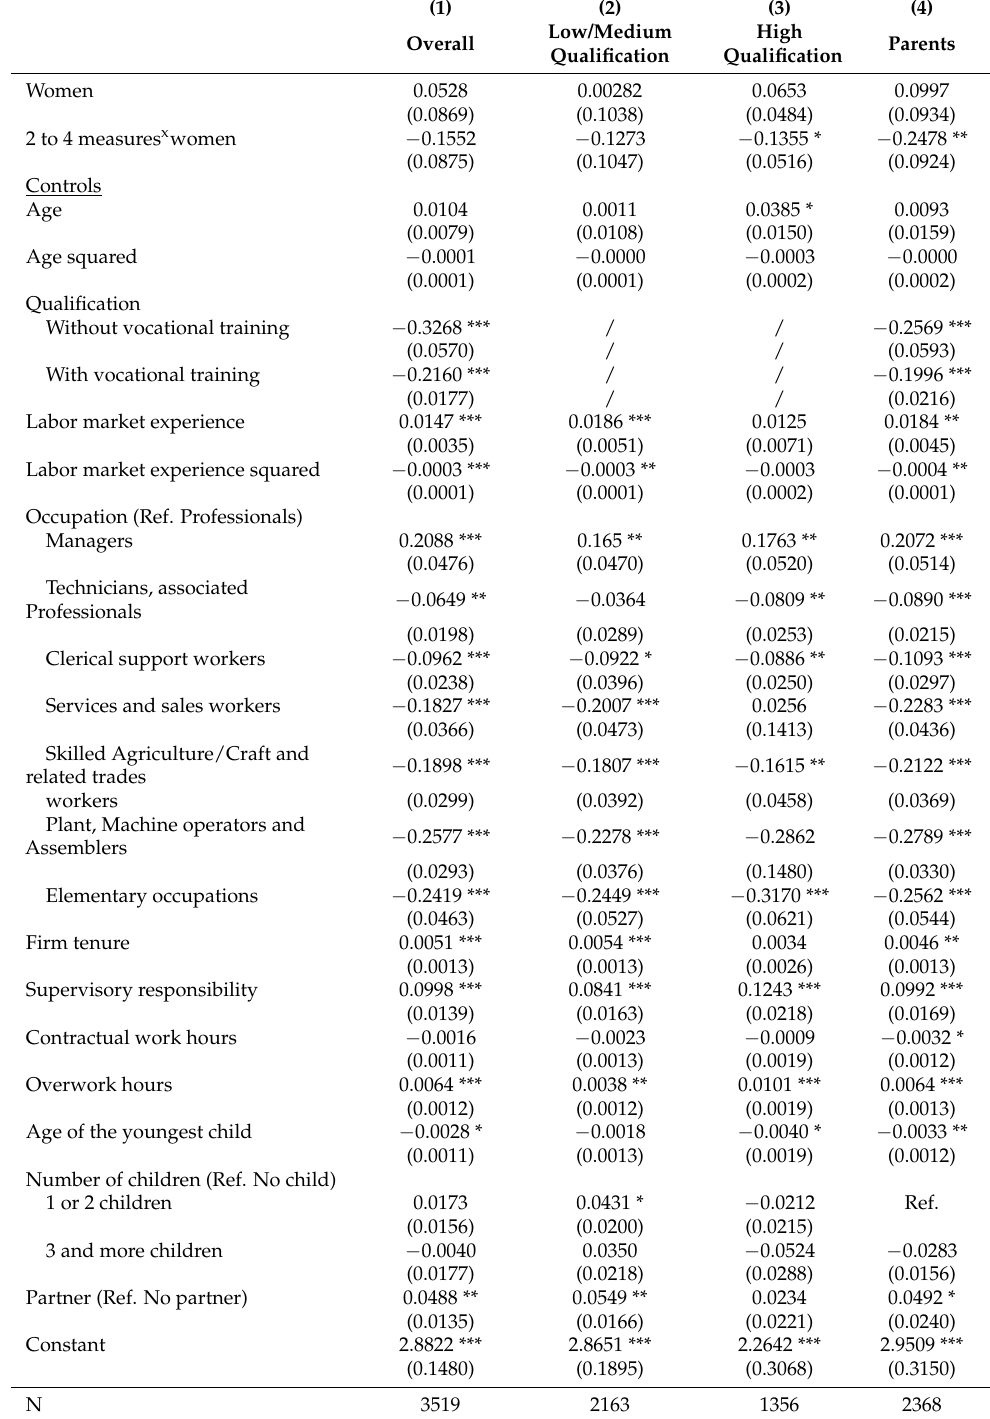
Table A13. The association of multiple WLM and log hourly wages within establishments with at least one EQM, including control variables (extended version of Table 5, step